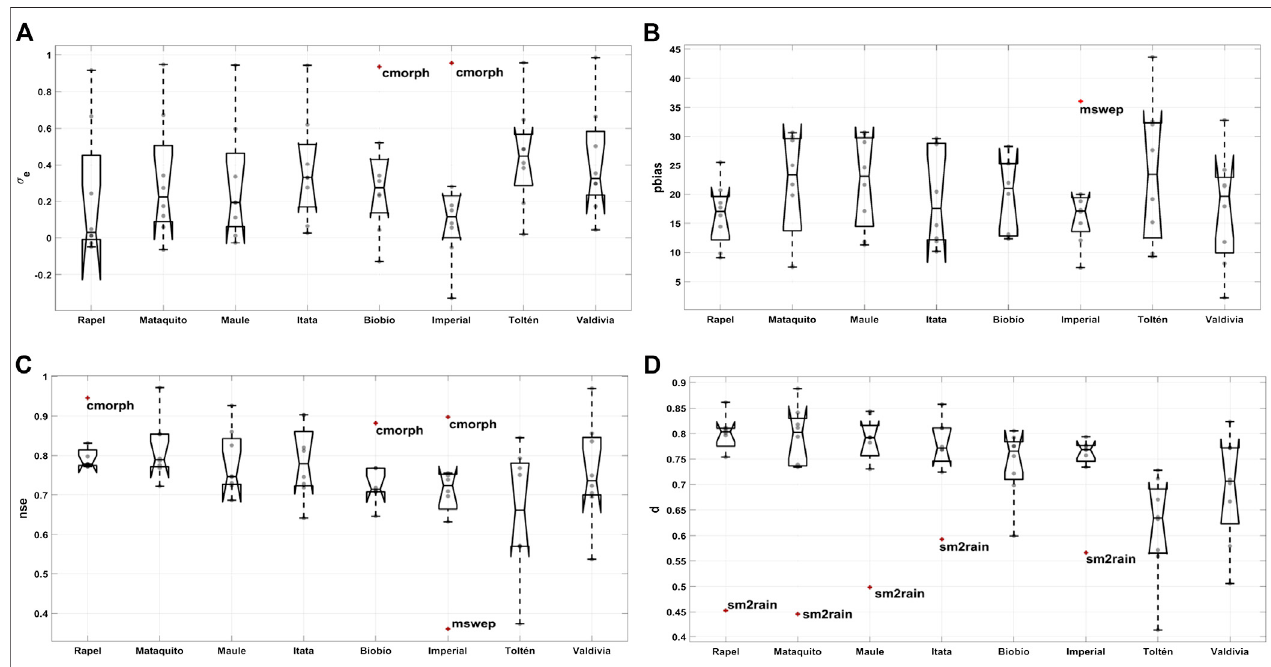
FIGURE 9 | Box diagrams corresponding to the gridded set performance ( Table 2 ), once adjusted ( Eq. 2 ) on the river basins of the area under study ( Figure 1B ). (A) Standardized standard deviation ( σ e ) , (B) percentage of the systematic error ( pbias ) , (C) Nash – Sutcliffe coef fi cient ( nse ) , and (D) Willmott coef fi cient ( d ) .